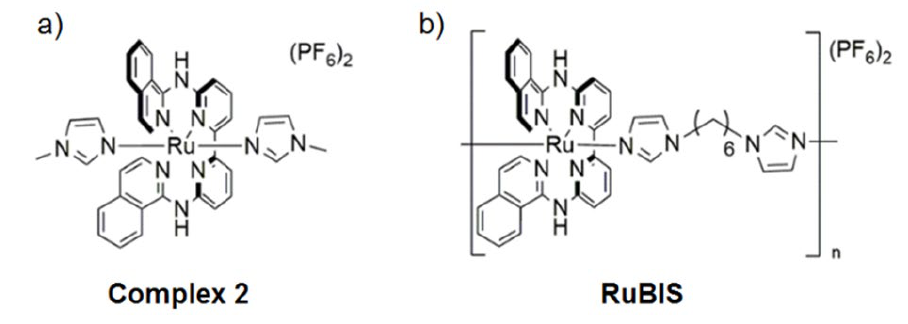
Figure 2. Chemical representation of complex 2 ( a ) and RuBIS CPNs ( b